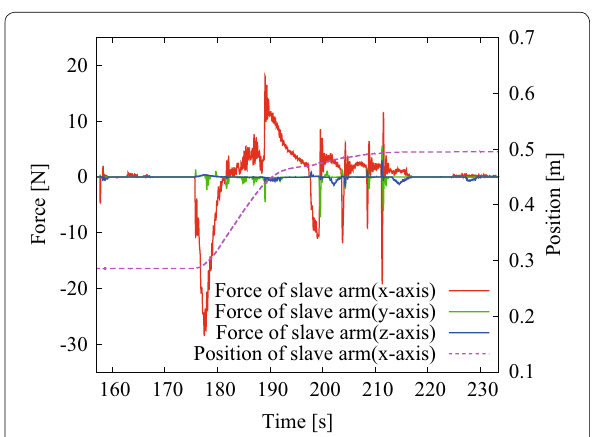
Fig. 14 Force of slave arm and position of slave arm (x-axis) (in HILS